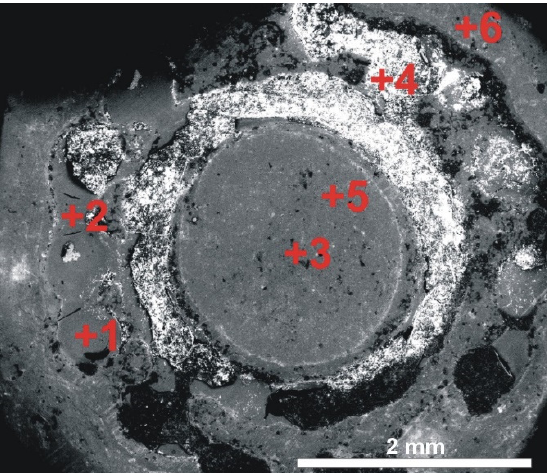
Figure 6. Backscattered electron (BSE) image of the blue bead surface with a white substance filling the bead ornamentation. For chemical analyses obtained at the points numbered 1–6, see Table 2. Table 2. Chemical composition, in weight percentage, of the side of the blue bead with ornamenta- tion. For all elements (except anion Cl), the composition is expressed as oxides weight %. The exact positions of the analysed points are shown in Figure 6.